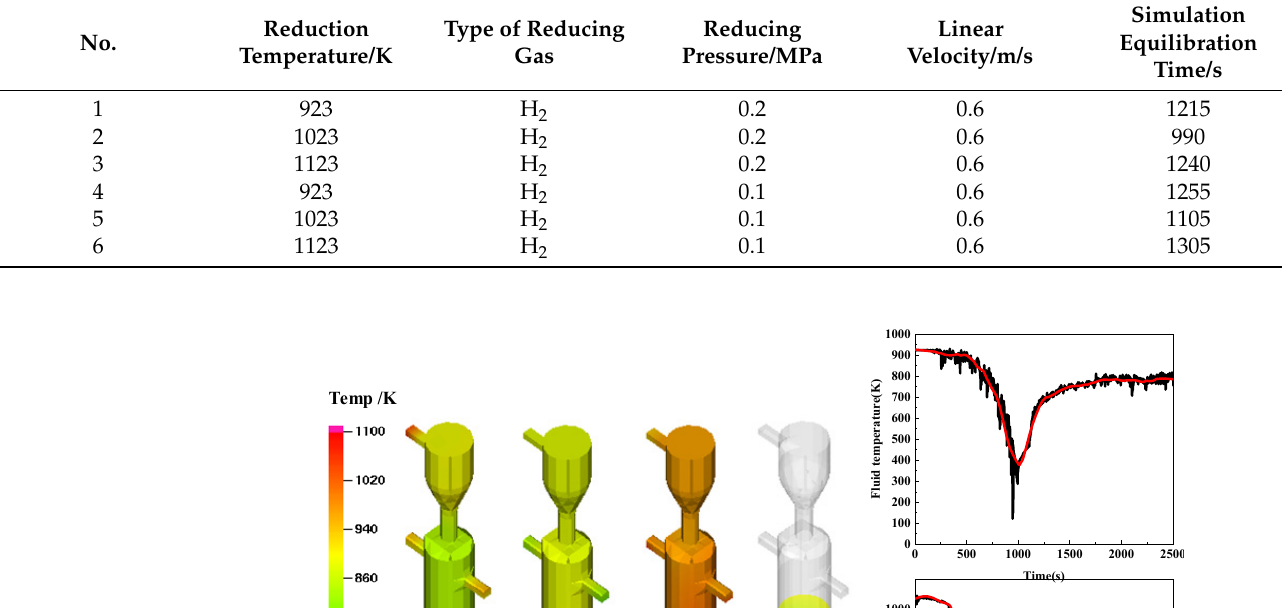
Table 6. Experimental scheme and results.